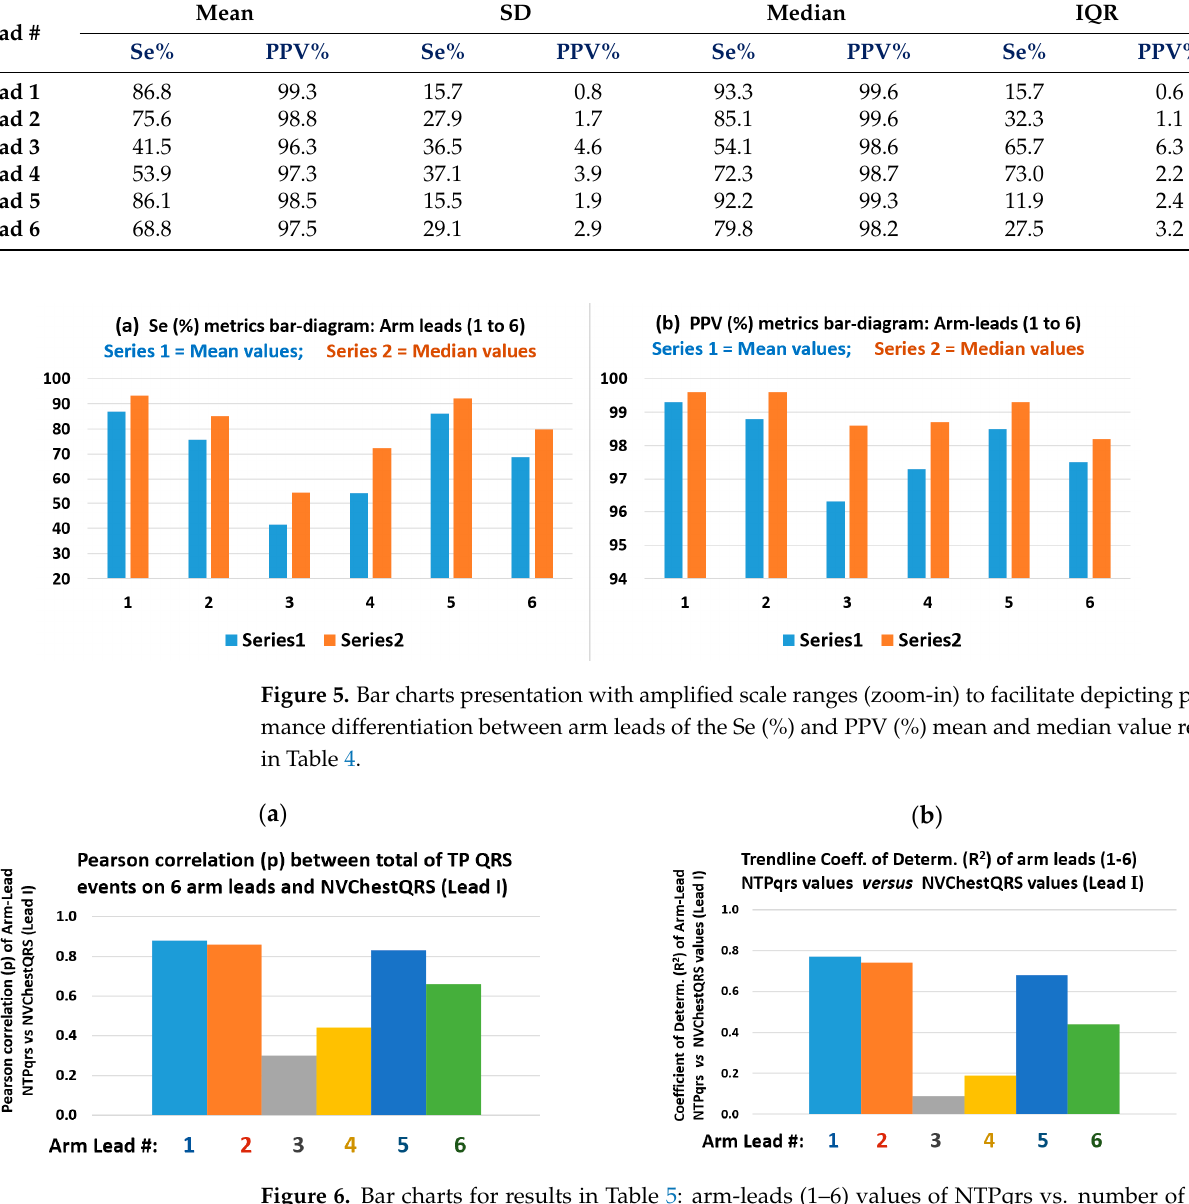
From the results of this QRS event detection and NTPqrs vs. NVChestQRS correlation performance study presented in Table 5 and in Figure 6, for the six arm leads, it can be comparatively observed that arm Lead-1, Lead-2 and Lead-5 presented the highest Pearson correlation (p) values: 0.88, 0.86 and 0.83, respectively, and also the highest scatter plot trendline Coefficient of Determination (R 2 ) values: 0.77, 0.74 and 0.68; and particularly revealing Lead-1 (axis at 0°) as the top performing arm-Lead for the arm-ECG QRS detection NTPqrs vs. NVChestQRS correlation metrics. Figure 7. Scatter plot of 18 data pair/case points and associated trendline coefficient of determination (R 2 ) of NTPqrs metric on arm leads (1– 6) versus values of NVChestQRS on the Chest Lead-I. 3.4. Arm Leads Comparative HRV Metrics Measurement Performance Analysis The HRV metrics results are presented in Table 6, in Figure 8 bar charts and in Figure 9 scatter plots. From the results summarised in Table 6 and Figure 8 on this particular QRS event detection assessment for measuring HRV RMS metric, on 8 min ECGs from the six defined bipolar arm leads in this 3rd-branch of study, which correlates the HRV RMS metric measured conventionally from the Chest Lead I ECG, with the simultaneously recorded arm-ECG leads, in the same subject case, as described in the Methods Section 2.4.5. In this 3rd-branch of study, arm Lead-1, Lead-2, Lead-5 and Lead-6 presented distinctively the highest correlation figures for the HRV RMS metric against the gold standard values measured in the Chest-Lead, both in p and R 2 coefficients values: p = 0.97 and R 2 = 0.95, p = 0.96 and R 2 = 0.93, p = 0.99 and R 2 = 0.98, p = 0.97 and R 2 = 0.93, respectively, as can be appreciated from Table 6. In contrast, arm Lead-3 and Lead-4 consistently presented the lowest HRV RMS correlation with Chest RMS values: p = 0.26 and R 2 = 0.07, p = 0.89 and R 2 = 0.80, respectively. Thus, these results are in agreement with the indications from the other study branches on best arm leads on QRS events discovery tendencies.